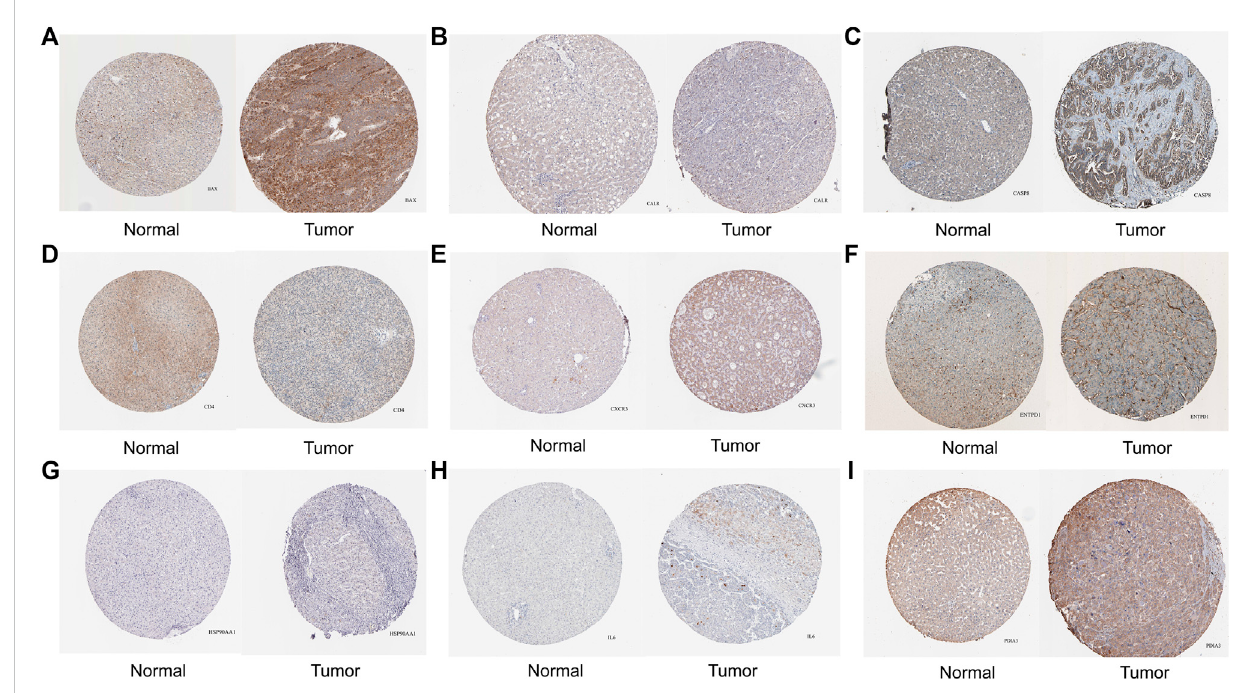
FIGURE 2 The protein level of ICD associated DEGs in normal liver and tumor tissues were detected by immunohistochemistry from the Human Protein Atlas database. [ (A) BAX, (B) CALR, (C) CASP8, (D) CD4, (E) CXCR3, (F) ENTPD1, (G) HSP90AA1, (H) IL6, (I) PDIA3; ICD: Immunogenic cell death, DEGs: Differentially expressed